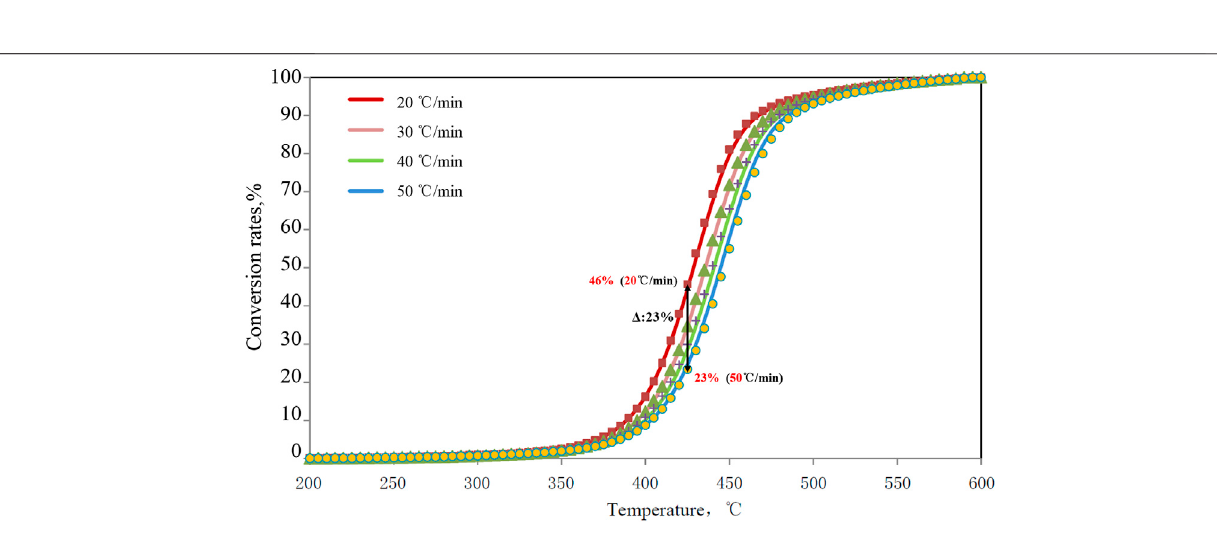
Frontiers in Earth Science |